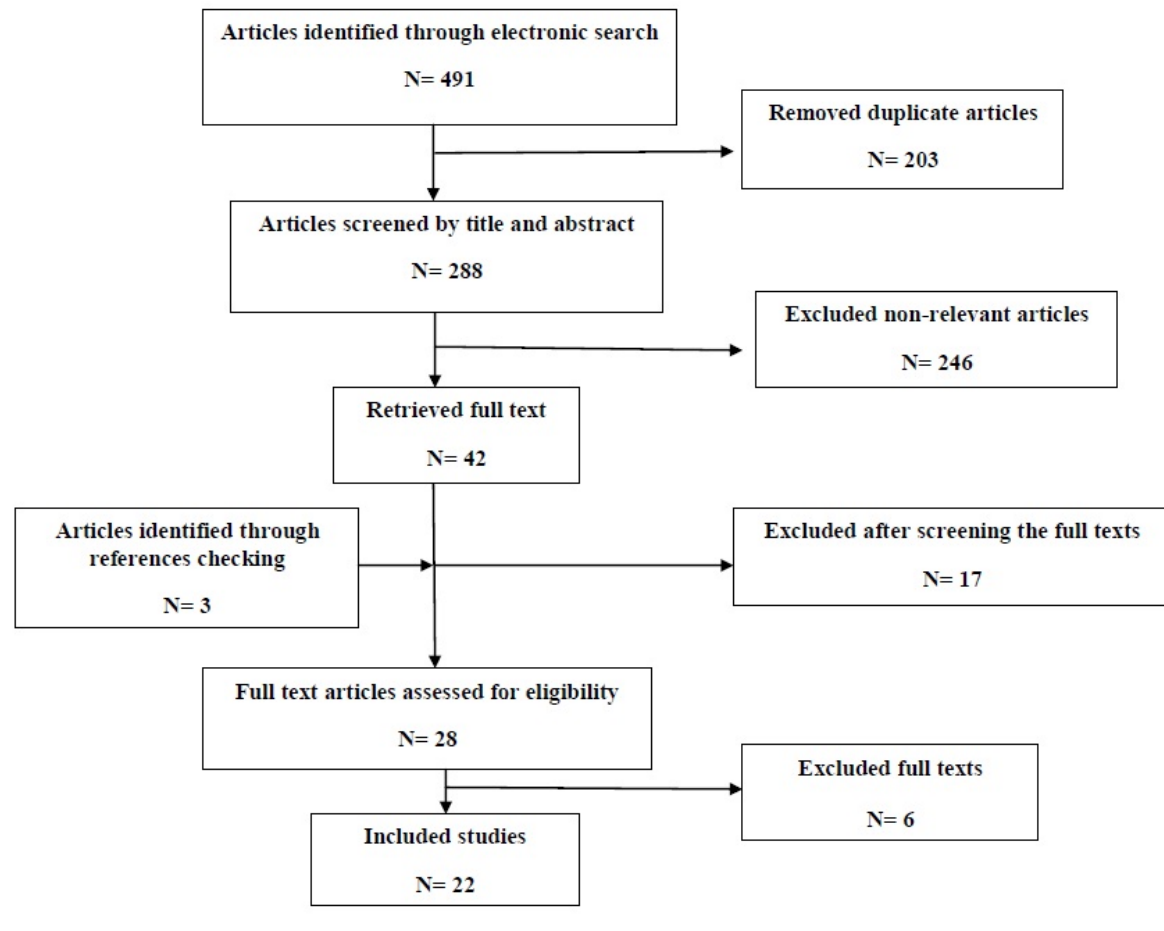
Figure 2. Literature search and review flowchart for the selection of primary